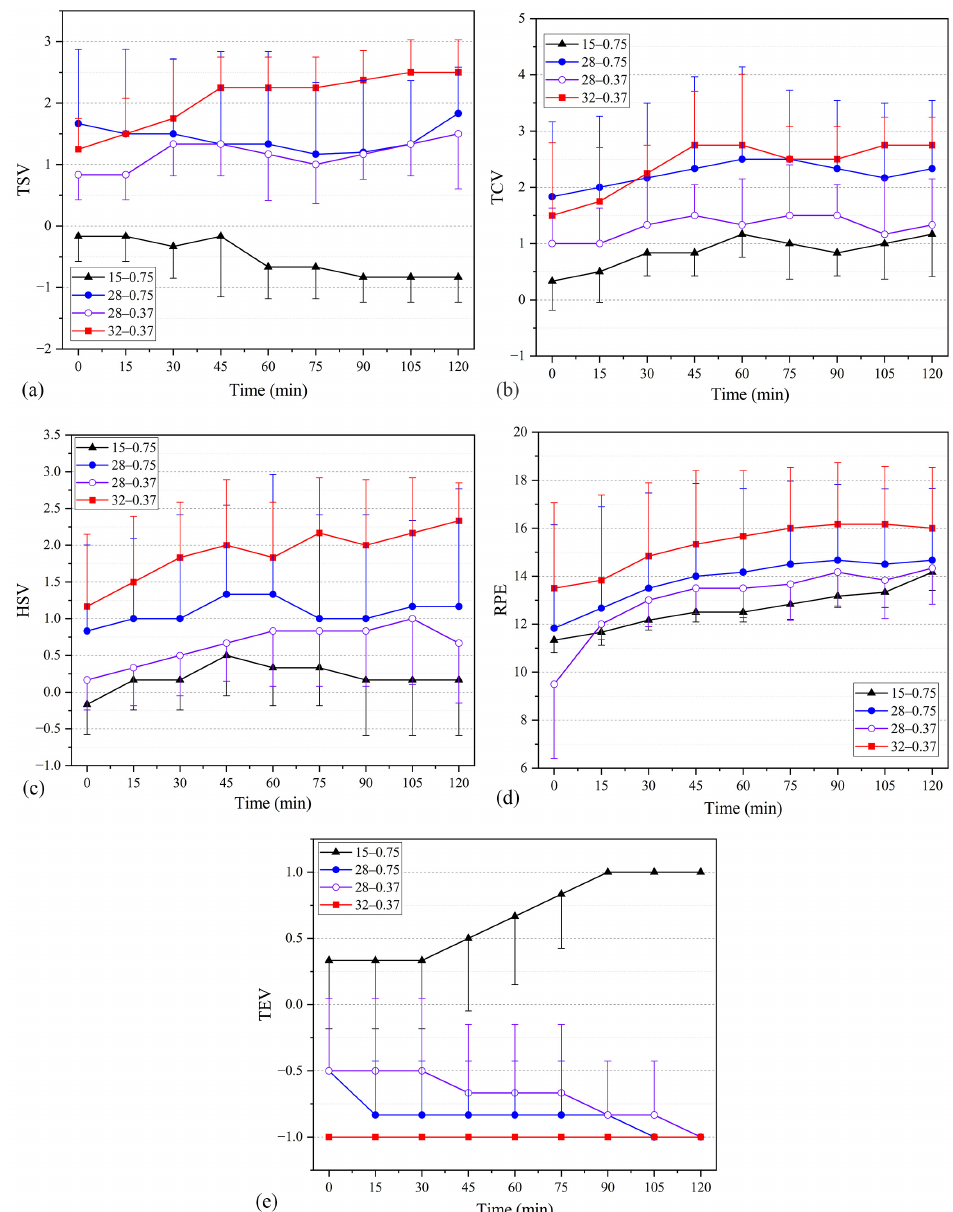
Figure 7. Temporal variations of thermal sensation votes, thermal comfort votes, humidity sensation votes, and ratings of perceived exertion under four different working conditions (i.e., 15 °C – 0.75 clo, 28 °C – 0.75 clo, 28 °C – 0.37 clo, and 32 °C – 0.37 clo; testing scenarios in the figures are presented as A–B, where A represents the WBGT value, and B represents the insulation of the inner garments used in the testing). ( a ) Thermal sensation votes. ( b ) Thermal comfort votes. ( c ) Humid sensation votes. ( d ) Borg’s rating of perceived exertion. ( e ) Thermal expectation